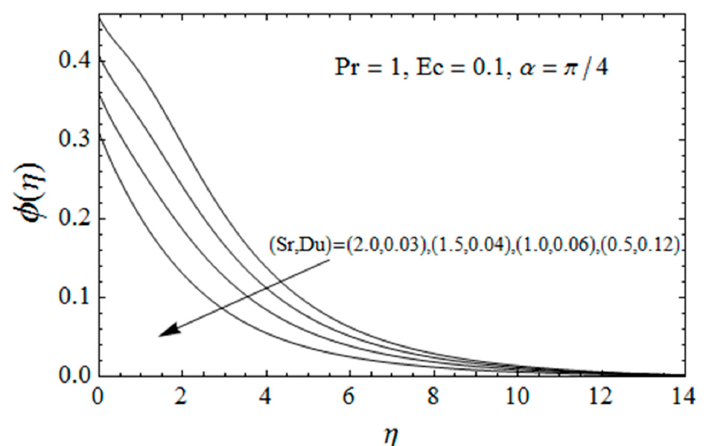
Figure 8. 𝜙(𝜂) for different 𝛽 (cid:3036)(cid:2870) .